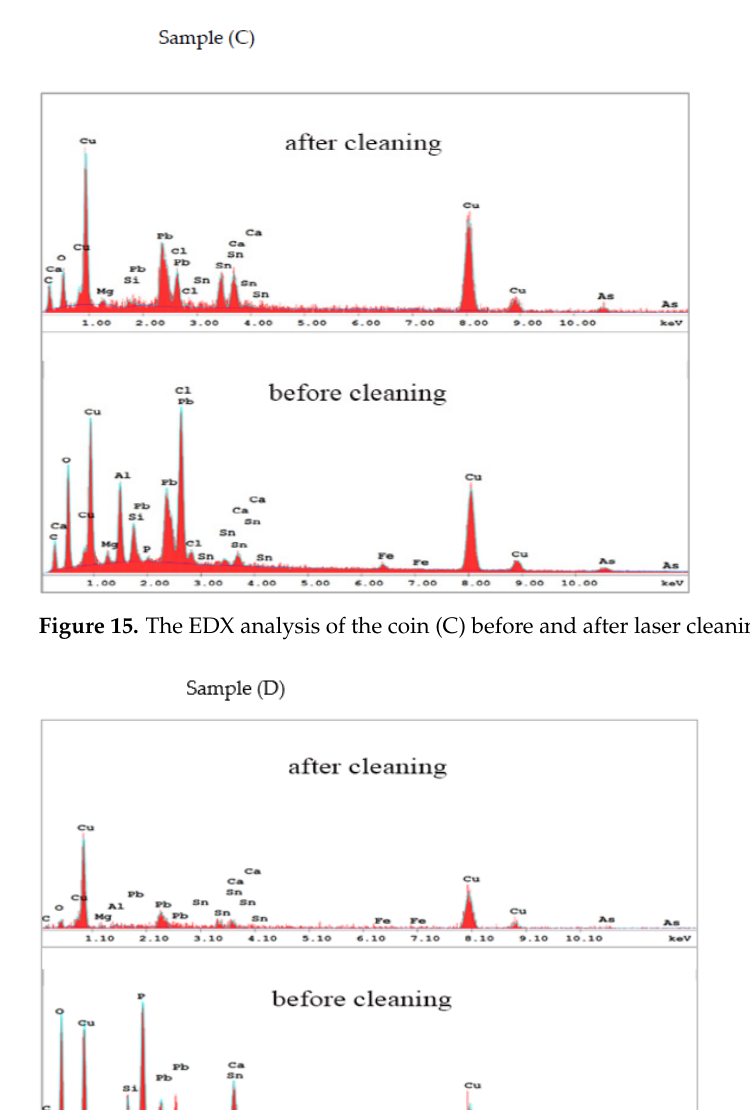
Figure 14. The EDX analysis of the coin (B) before and after laser cleaning.